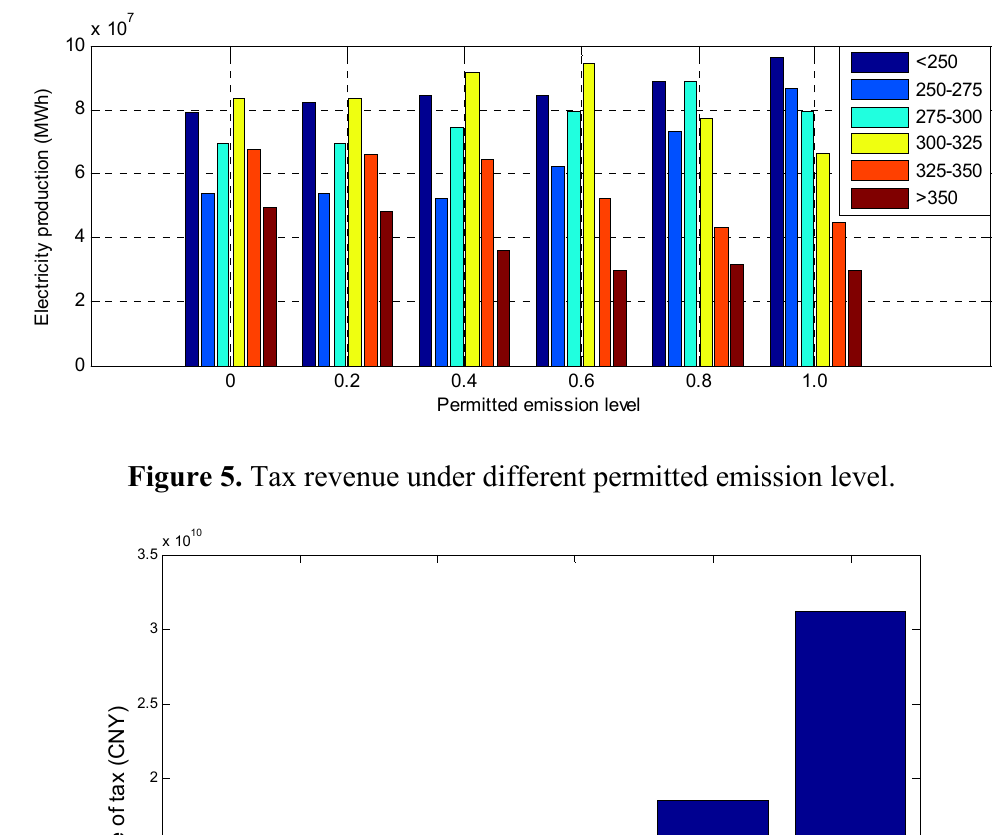
Figure 4. Electricity production of each group under different permitted emission level.